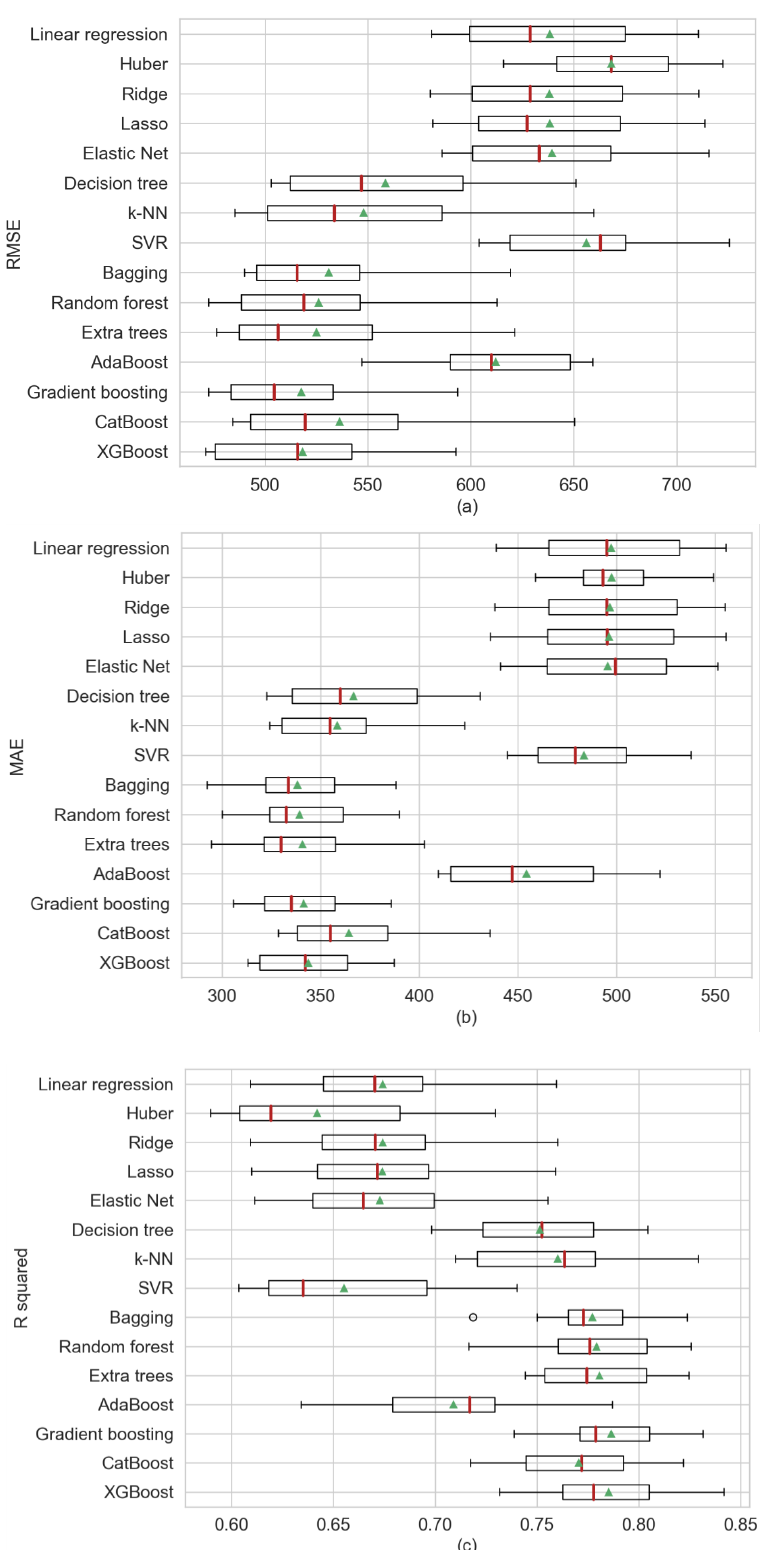
Figure 6. Comparative algorithm analysis using 10-fold cross-validation over observable and forecast weather data analyzing ( a ) RMSE, ( b ) MAE, ( c ) R 2 as scoring metric.